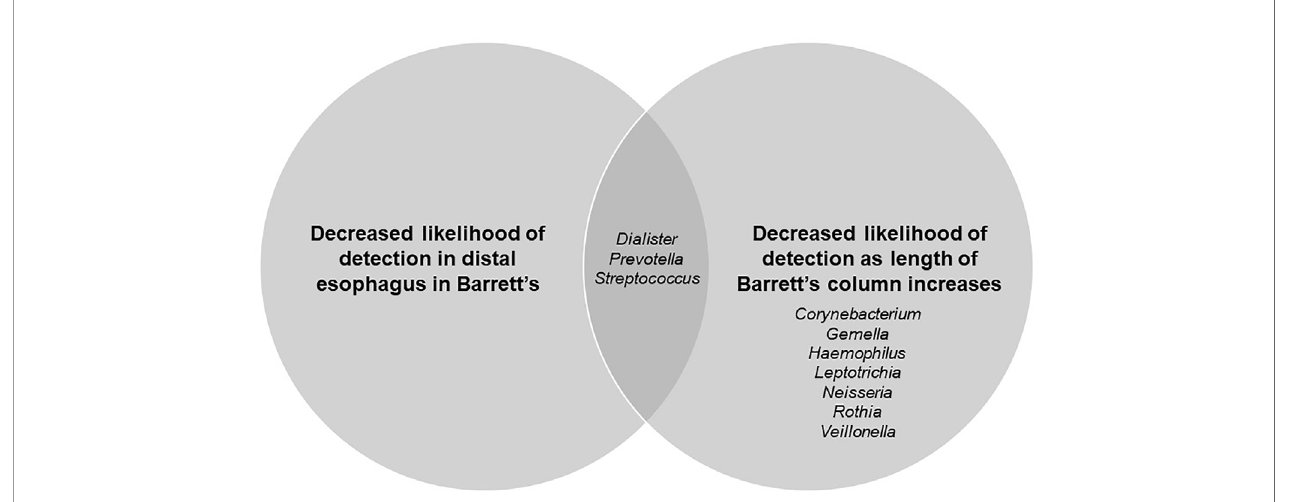
FIGURE 4 | Venn diagram showing genera signi fi cantly related to presence/absence of Barrett ’ s esophagus and length of Barrett ’ s